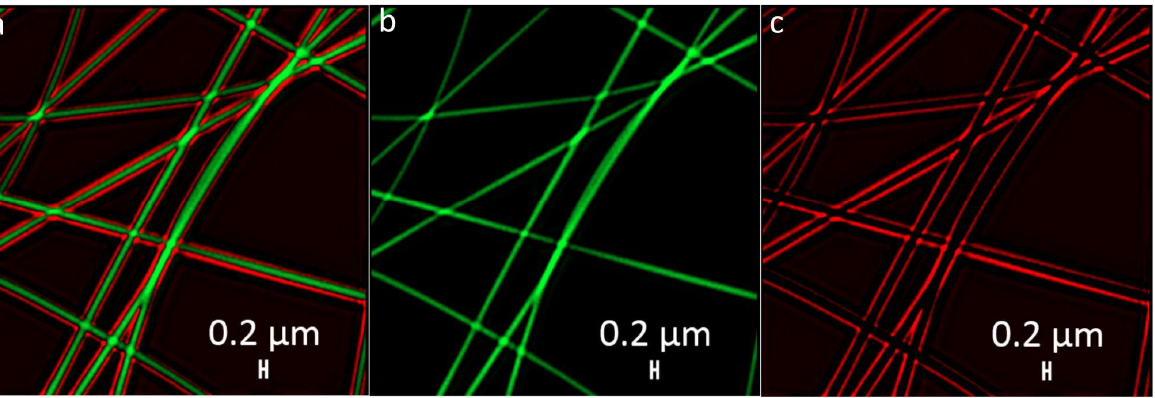
Figure 6. Representative fluorescence microscopy images collected from: ( a ) core-shell PVA–PEG– SiO 2 @PVA–GO fibers with the labelled bilayered structure; ( b ) FITC represents the core in green; ( c ) Rhodamine B indicates a shell of fiber colored in red.